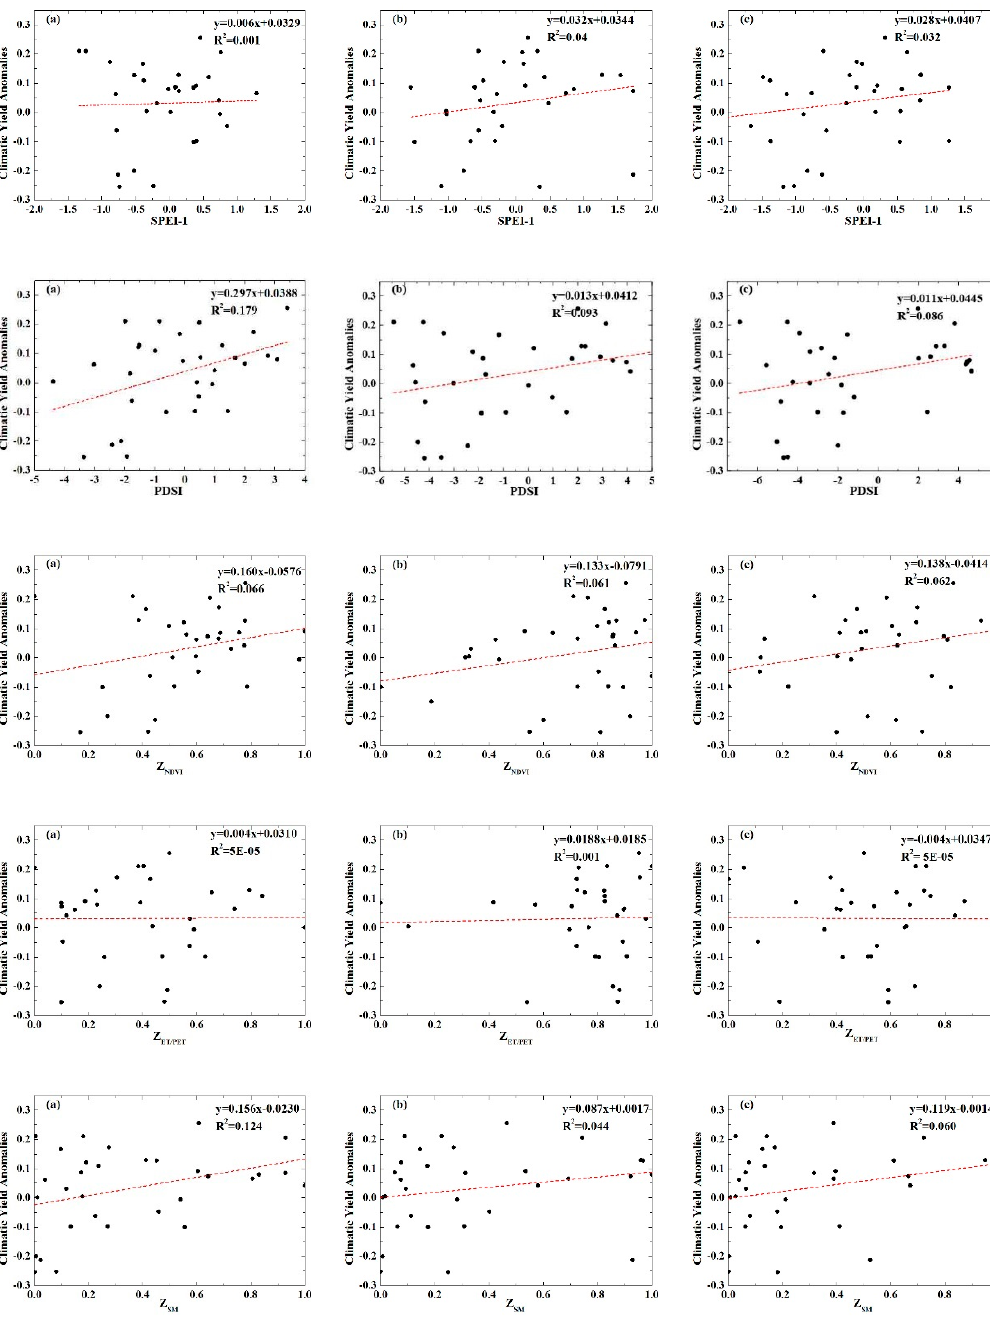
Figure 10. Scatter plot and linear fitting line among SPEI-1, PDSI, Z NDVI , Z ET/PET , Z SM , and climatic yield anomalies for maize at different growth stages from 1985 to 2015. ( a – c ) Represent the stages of emergence-tasseling stage, tasseling-milky maturity, and milky maturity-mature, respectively.